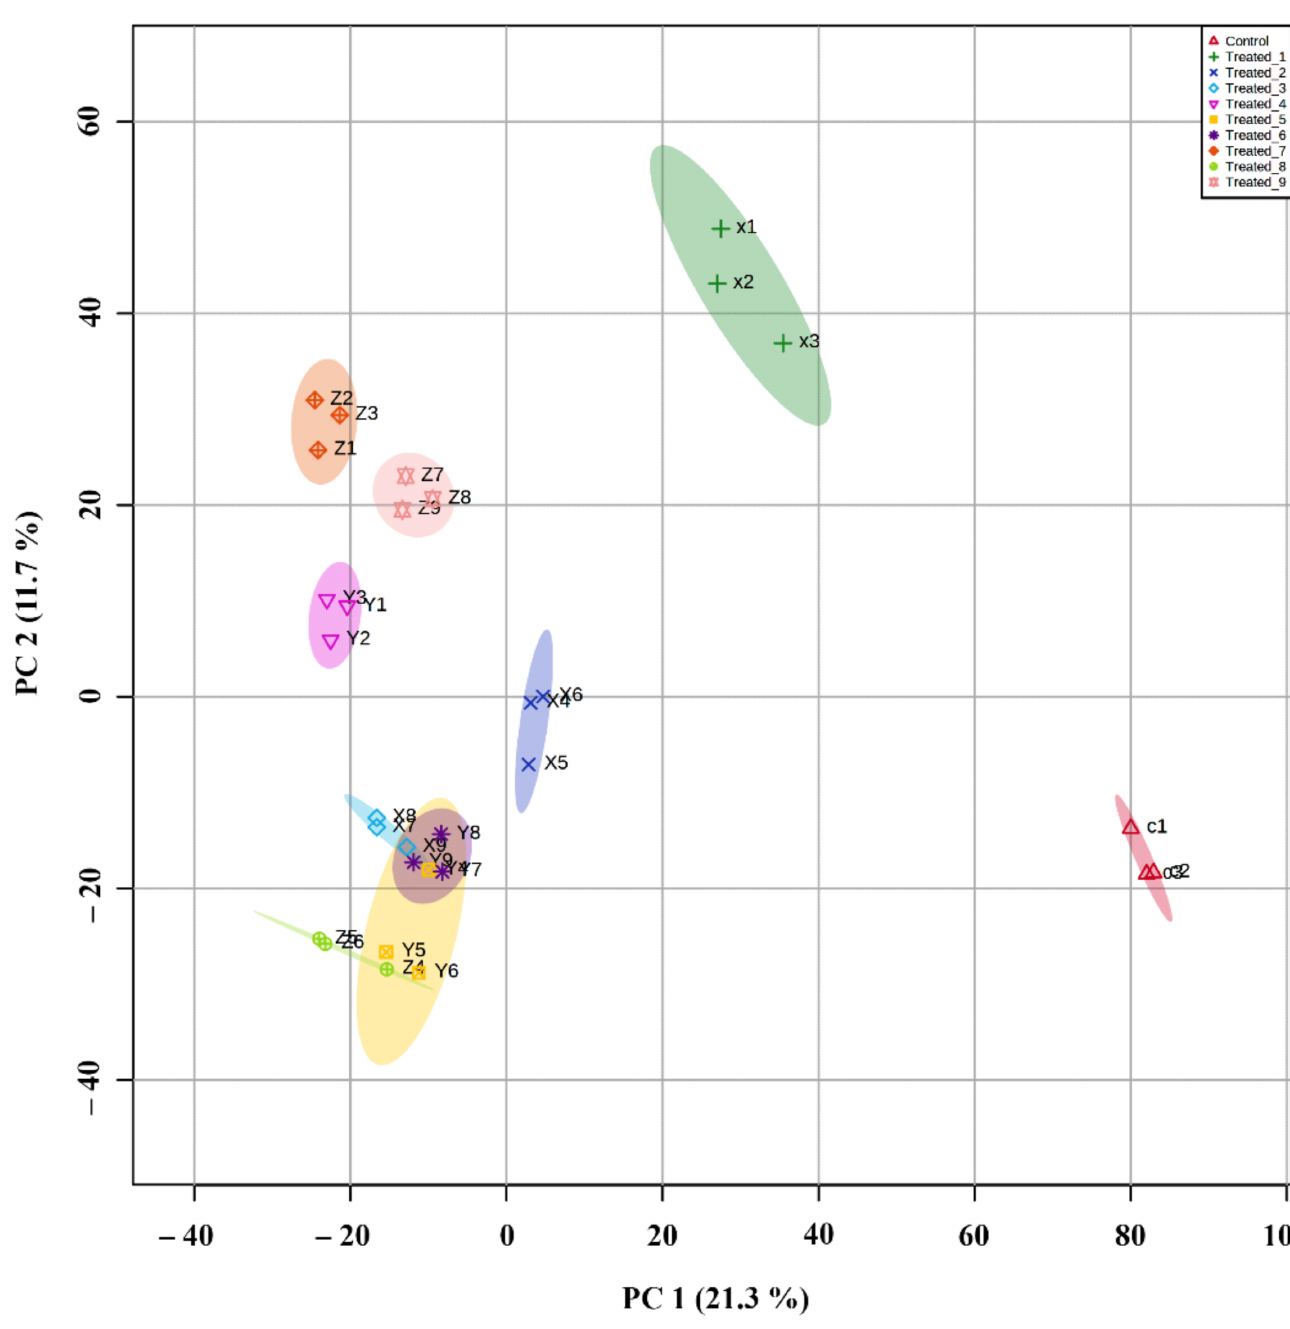
Figure 11. PCA analysis between the significantly produced metabolites and a plot showing the separation of the stressed